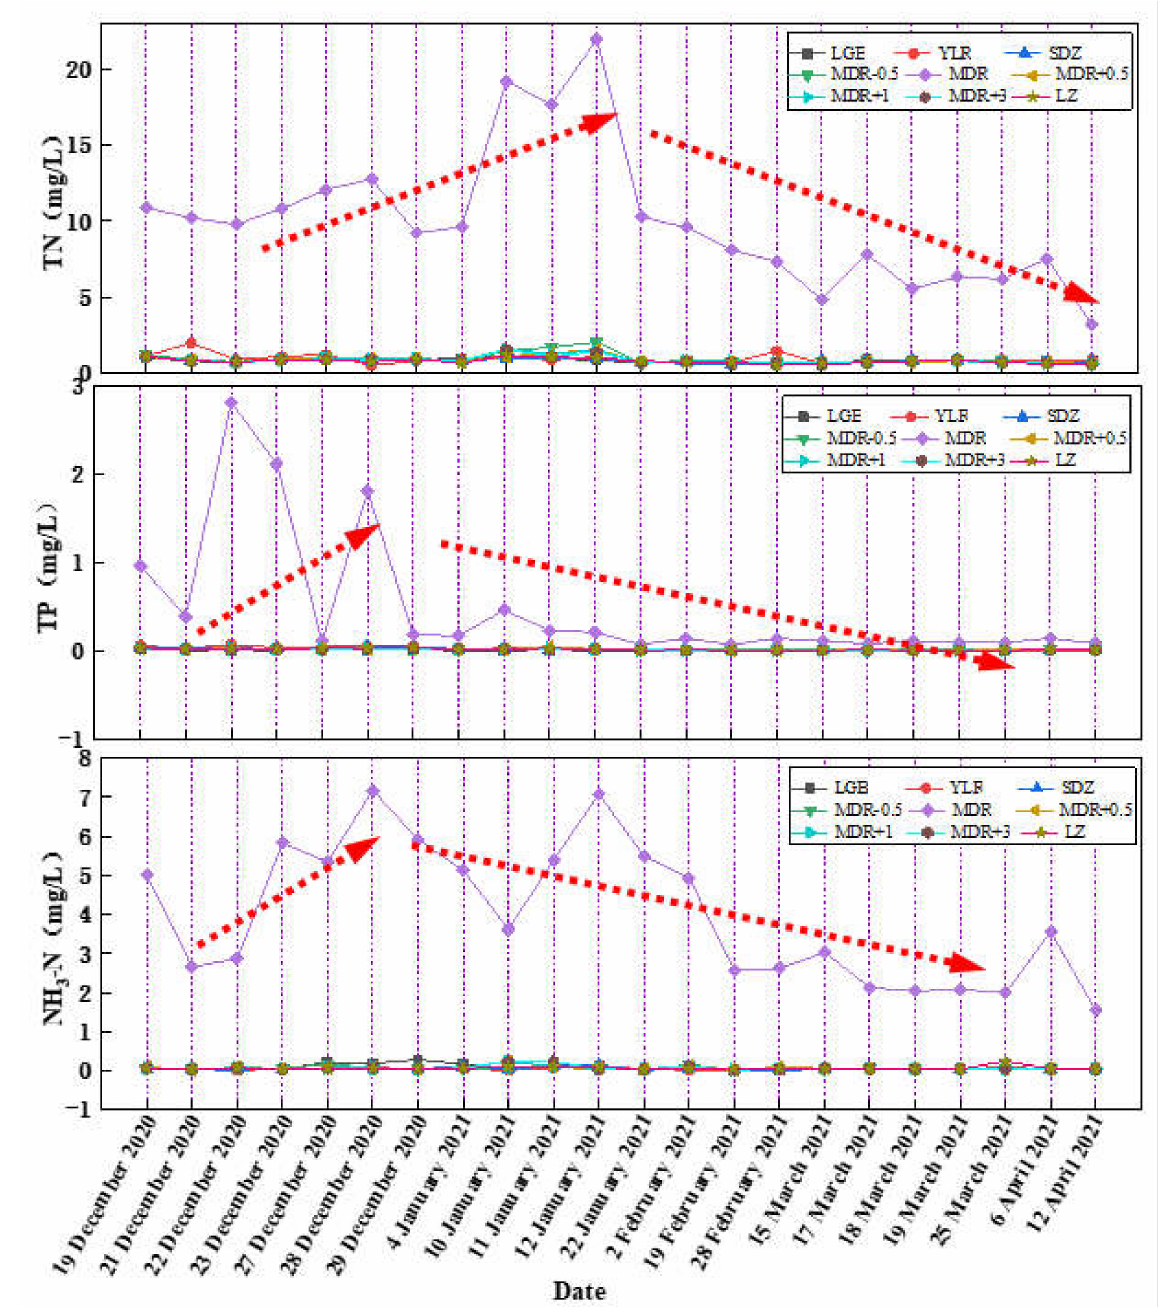
Figure 10. Changes in nutritional parameters at each monitoring point during the impoundment test stage (2020–2021). Luoguo Bridge, LGB; Yalong River, YLR; Sanduizi, SDZ; 0.5 km upriver of Madian River, MDR − 0.5; Madian River, MDR; 0.5 km downstream of Madian River, MDR + 0.5; 1 km downstream of Madian River, MDR + 1; 3 km downstream of Madian River, MDR + 3; Lazha, LZ. As shown in the statistical data in Table 5, the minimum, maximum, and mean values of each index monitored in the Madian River section were much larger than those of the other sections. Comparatively speaking, the fluctuation range of each parameter index in the other sections, except the Madian River section, was small. For the oxidation parameters, BOD 5 , COD Mn , and DO ranged from 0.25–1.4, 0.84–1.656, and 8.75–10.34 mg/L, respectively. For the nutritional parameters, NH 3 -N, TN, and TP ranged from 0.0125–0.282, 0.49–2.03, and 0.005–0.07 mg/L,